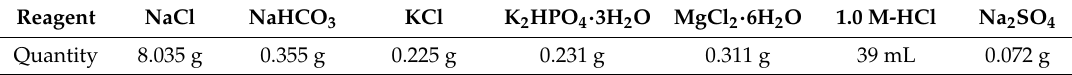
Table 2. Reagents and doses for 1000 mL